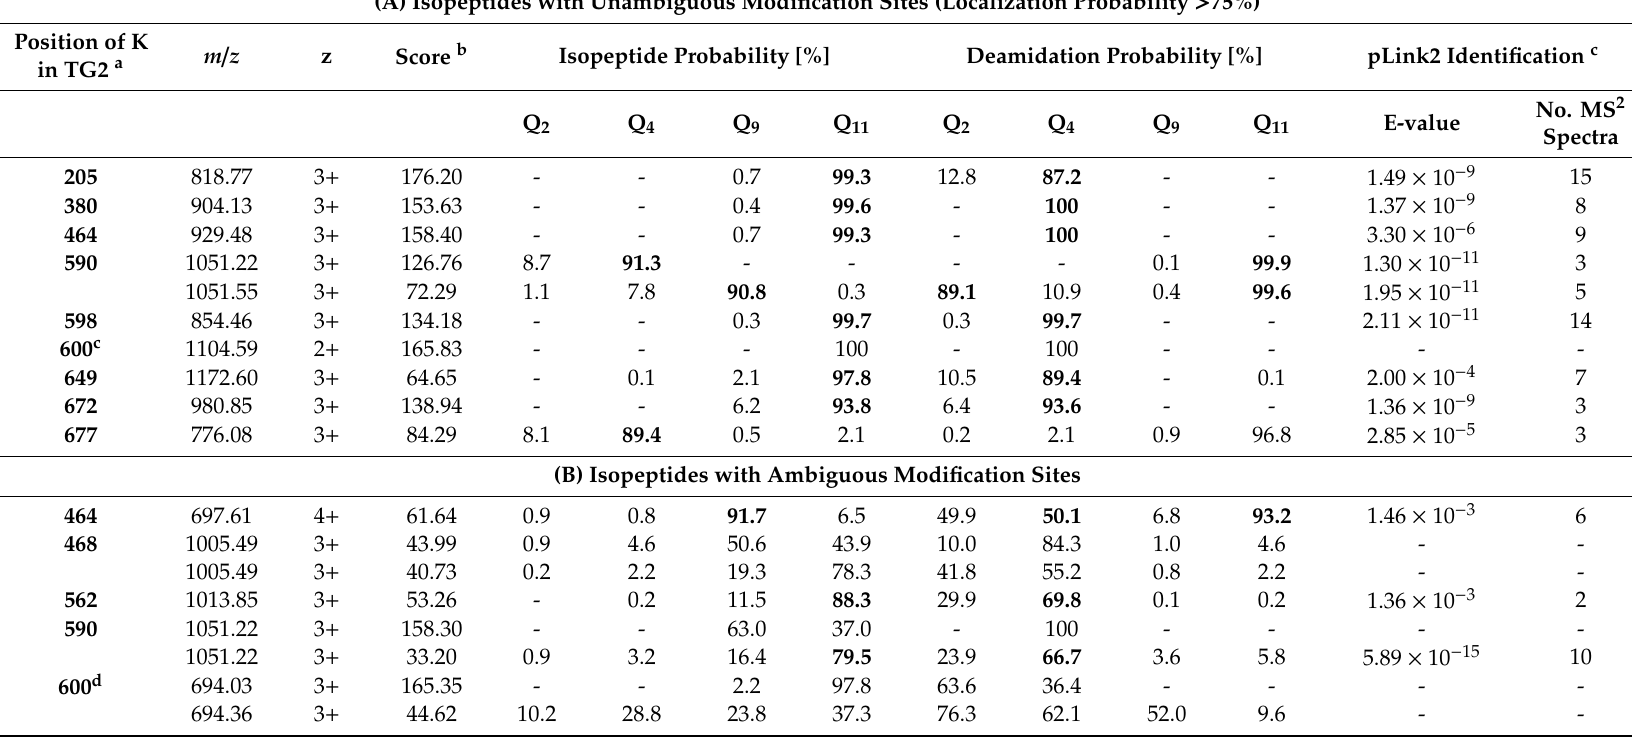
Table 3. Glutamine binding and deamidation sites in P1 (PQ 2 PQ 4 LPYPQ 9 PQ 11 LPY) involved in the formation of 22 isopeptides with di ff erent lysine residues of TG2. Modified sites identified with pLink2 are given in